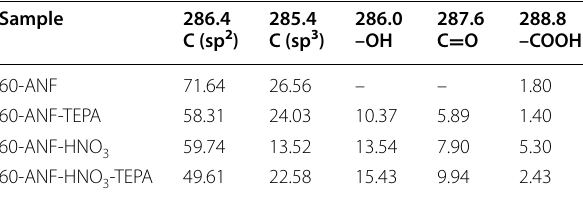
Table 3 Quantitative results of the fits of the XPS C